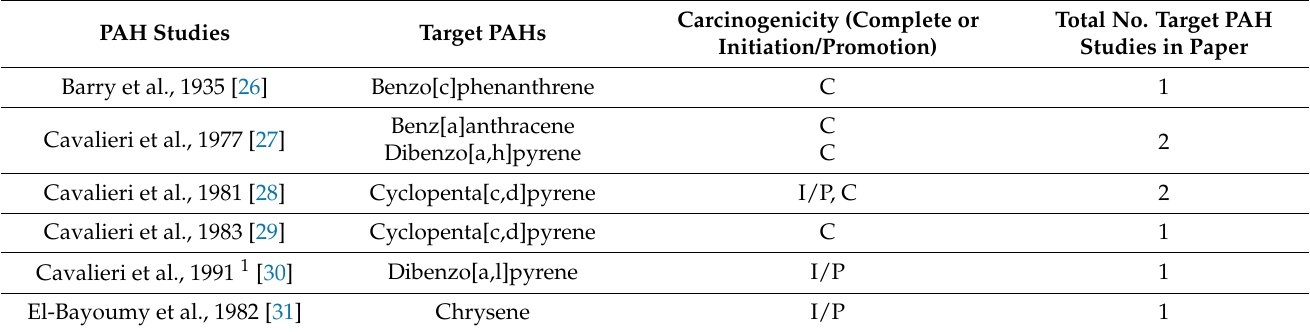
Table 4. List of References Selected by A Priori Criteria with Number of Studies, Type of Studies, and Target PAHs